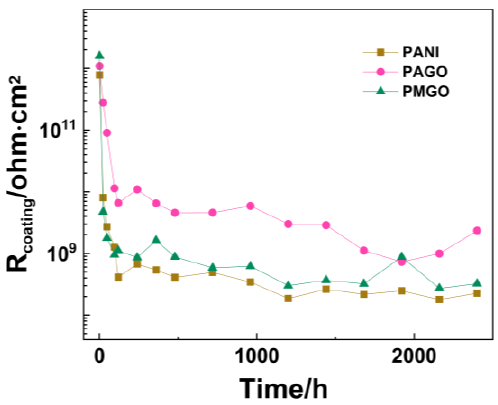
Figure 9. Variation curve of coating resistance with immersion time .